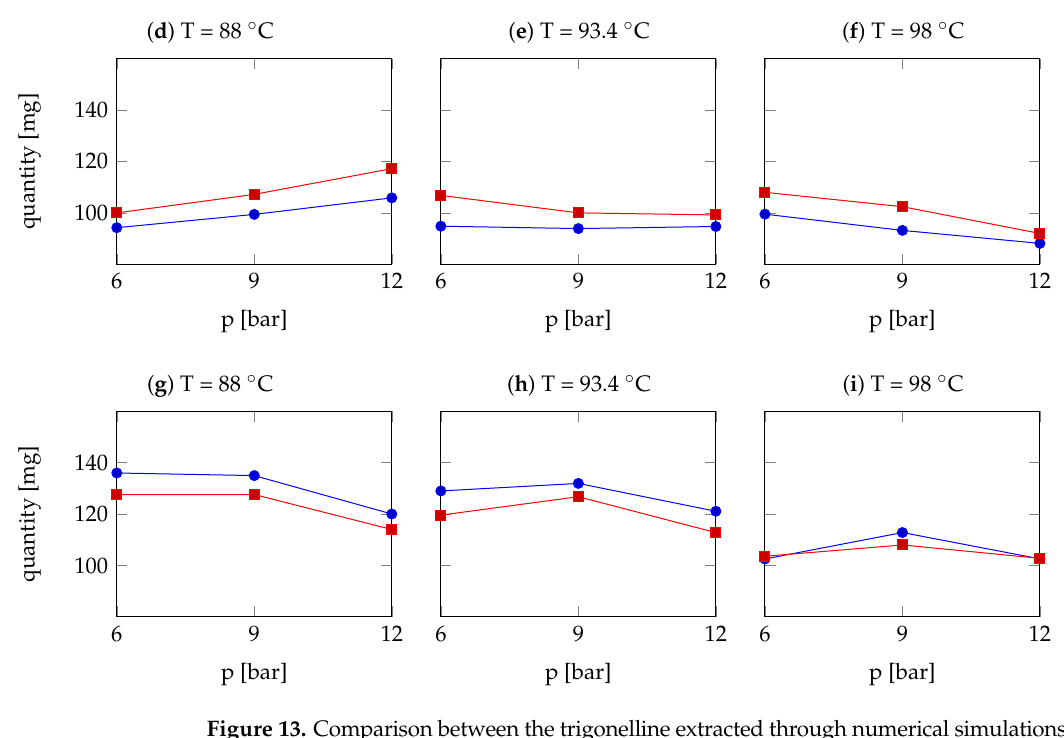
Figure 13. Comparison between the trigonelline extracted through numerical simulations (blue profile with circles) and laboratory measurements (red profile with squares), with different inlet water tempera- tures and pressures and different grain size of Robusta coffee powder. Figures ( a – c ) show the results of optimal granulometry, Figures ( d – f ) of coarse granulometry and Figures ( g – i ) of fine granulometry. ( a ) T = 88 ◦ C